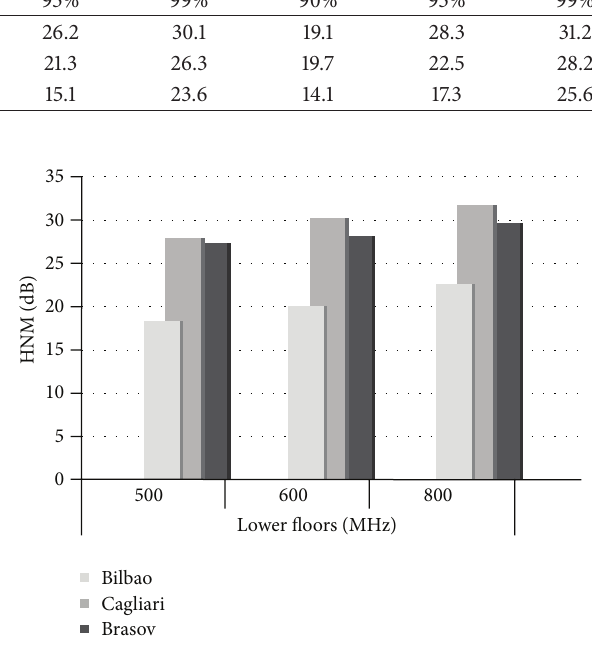
Figure 8: HNM for the three cities in rural